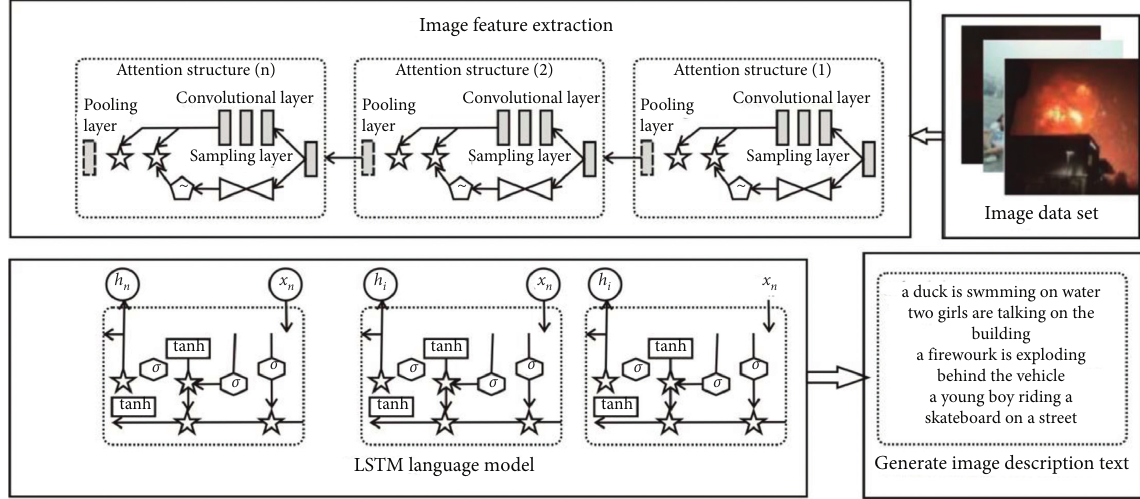
Figure 1: The image description generation algorithm of the concentrated feature extraction